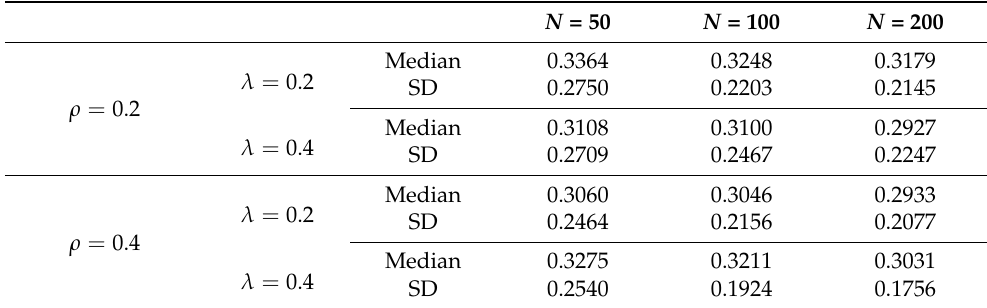
Table 3. The medians and SDs of MADEs for nonparametric estimates under the model (12) with T = 10.